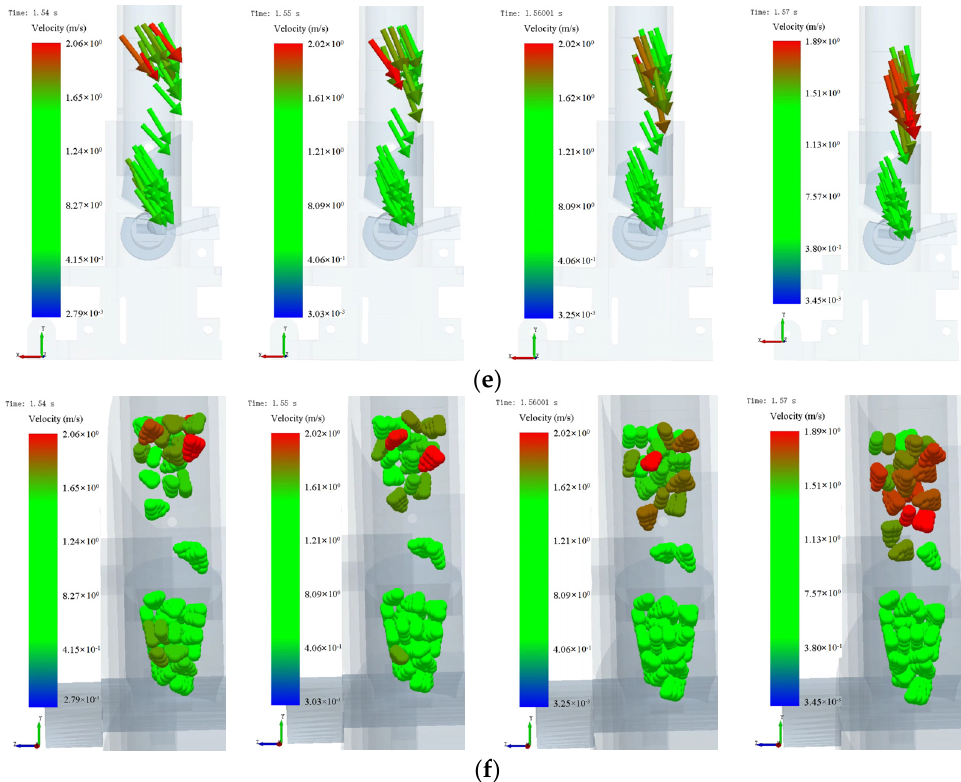
Figure 20. Movement process of maize in the seed tube with inverted hook added for guiding seed. ( a ) Default display of left view. ( b ) Vector display of left view. ( c ) Default display of front view. ( d ) Default display of left view. ( e ) Vector display of left view. ( f ) Default display of front view.